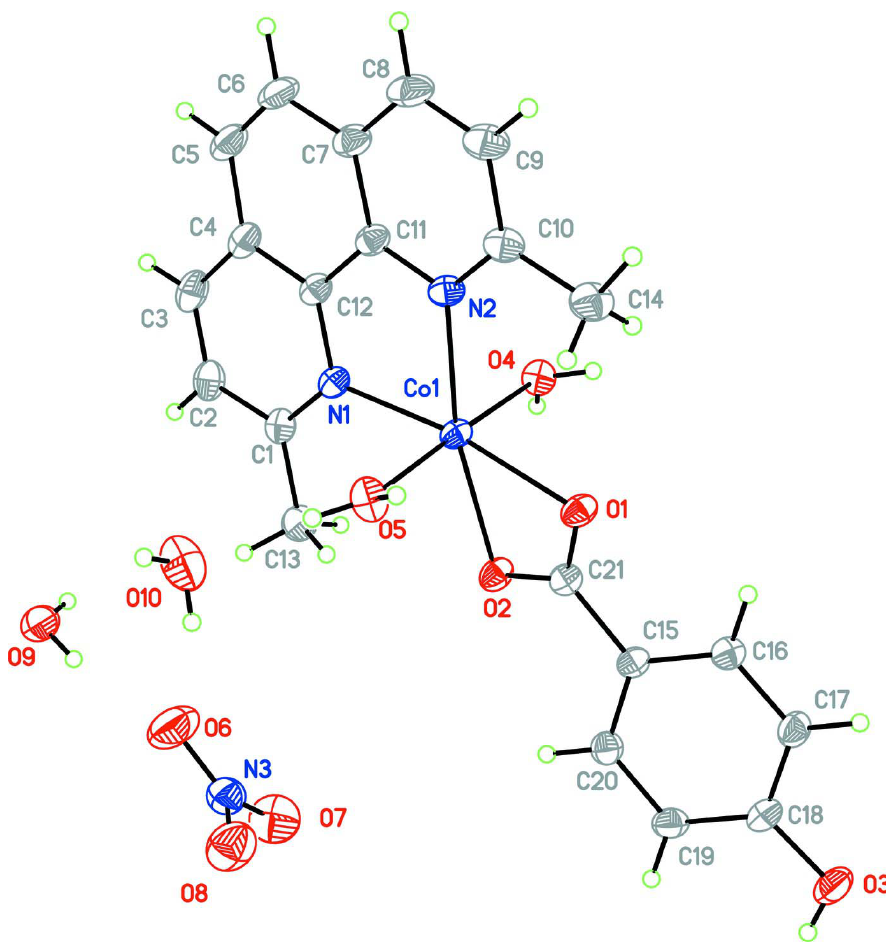
Figure 1 The molecular structure of the title compound, with atom labels and 30% probability displacement